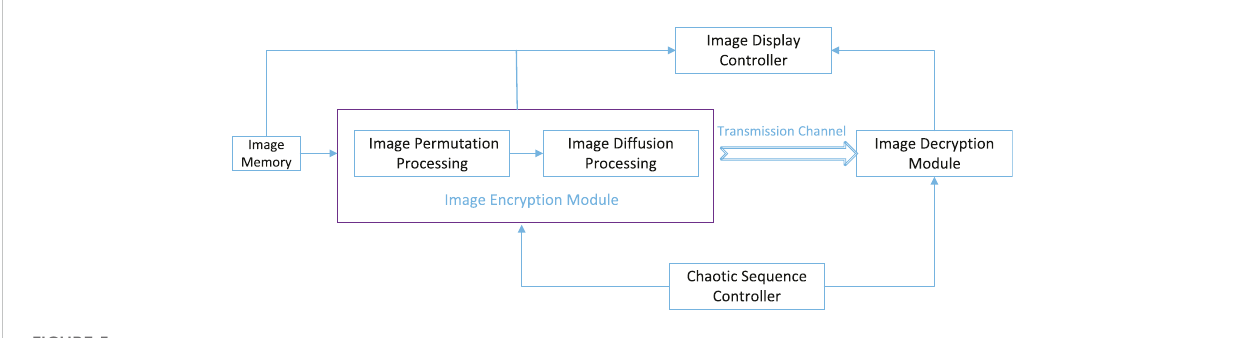
FIGURE 5 Structural diagram of FPGA-based image encryption and decryption.